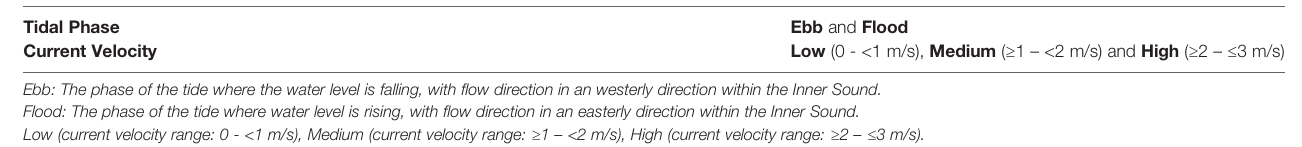
TABLE 3 | Hydrodynamic variables used in examination of relative orientation, density distribution and multitype pairwise correlation function.